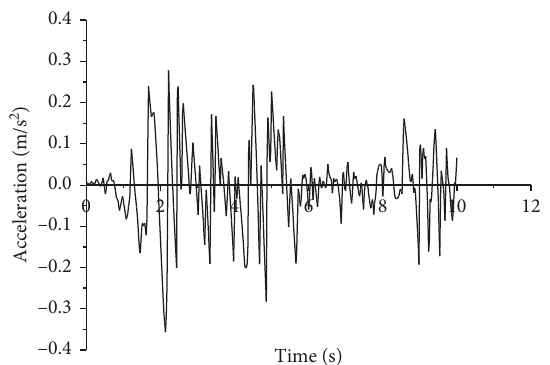
Figure 3: EI-Centro (NS) earthquake